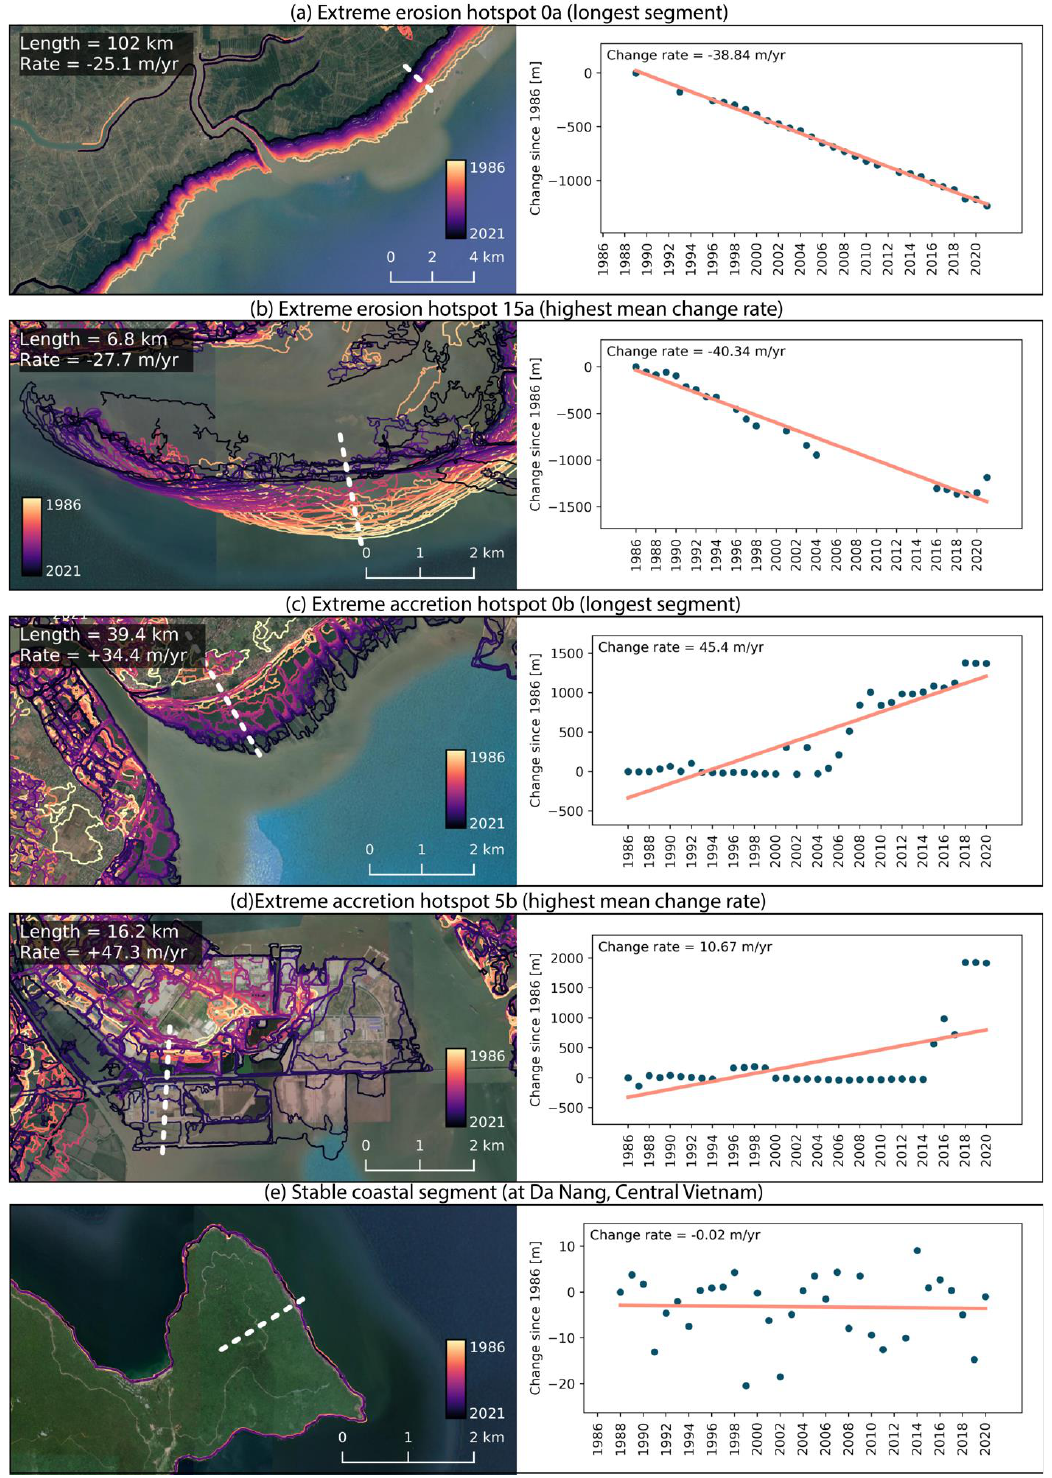
Figure 13. Left : Mean annual coastlines (1986 – 2021) at selected hotspots overlaid by a sample transect (white-dotted line). Right : The time series graph of the coastline positions relative to the earliest coastline position on the sample transect. For the location of the hotspots, see Figure 9.